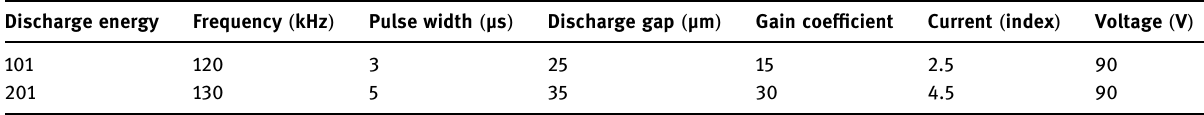
Table 2: Detailed electrical parameters Discharge